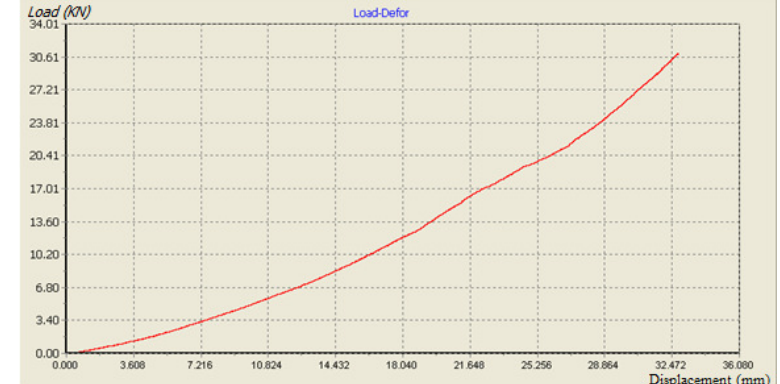
Fig. 10. Forming load-displacement chart result in multi-point forming